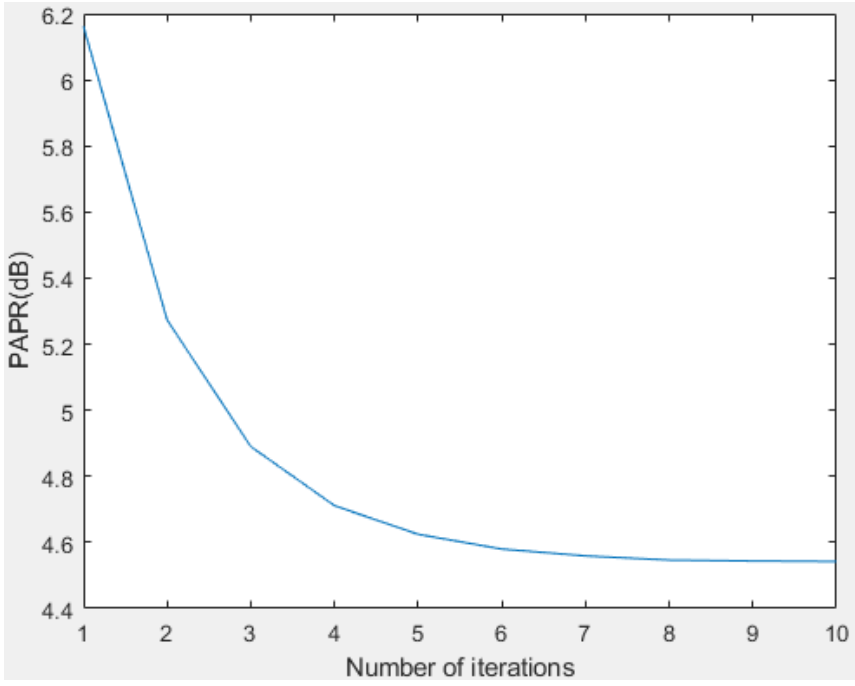
Figure 12. PAPR vs. the number of iterations for N =